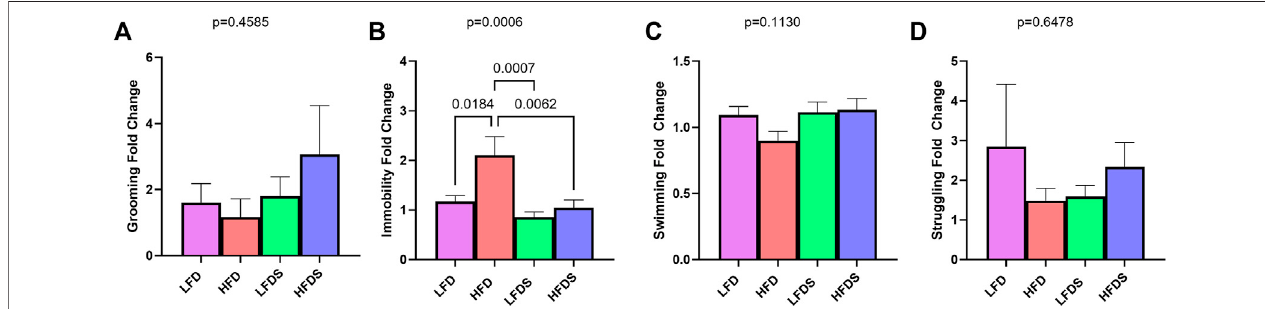
FIGURE 2 | Assessment of anhedonia-like and despair-like behavior after HFD and/or STU stress. (A) Grooming activity in SGT in all groups. (B – D) Immobility, swimming,andstrugglingfromFST.Datarepresentedasmean±SEM.Samplesizeforrats:LFD=24,HFD=24,LFDS(low-fatdietStress)=24,andHFDS(high-fatdiet Stress) = 23. Statistic used, One-way ANOVA with Tukey ’ s multiple comparison test.